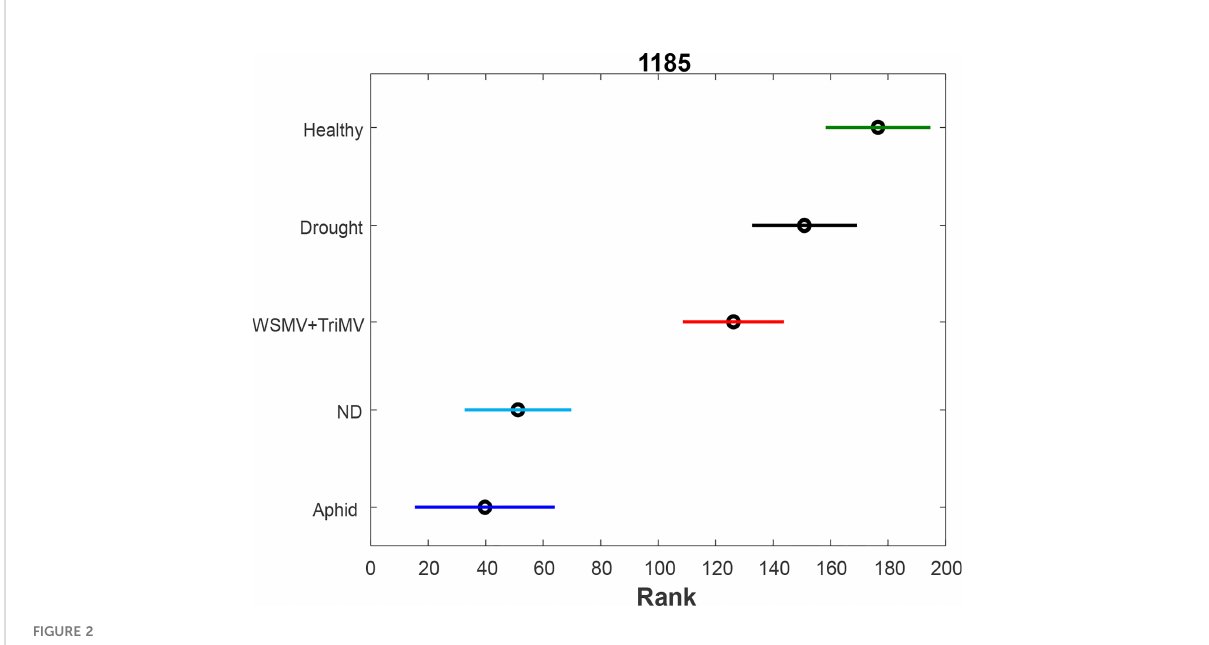
FIGURE 2 ANOVA (A) of carotenoid vibration (1185 cm-1) in the spectra of healthy (green), ND- (light blue) and drought (black) stressed plants, as well as wheat exposed to WSMV+TriMV infection (red) and aphid stress